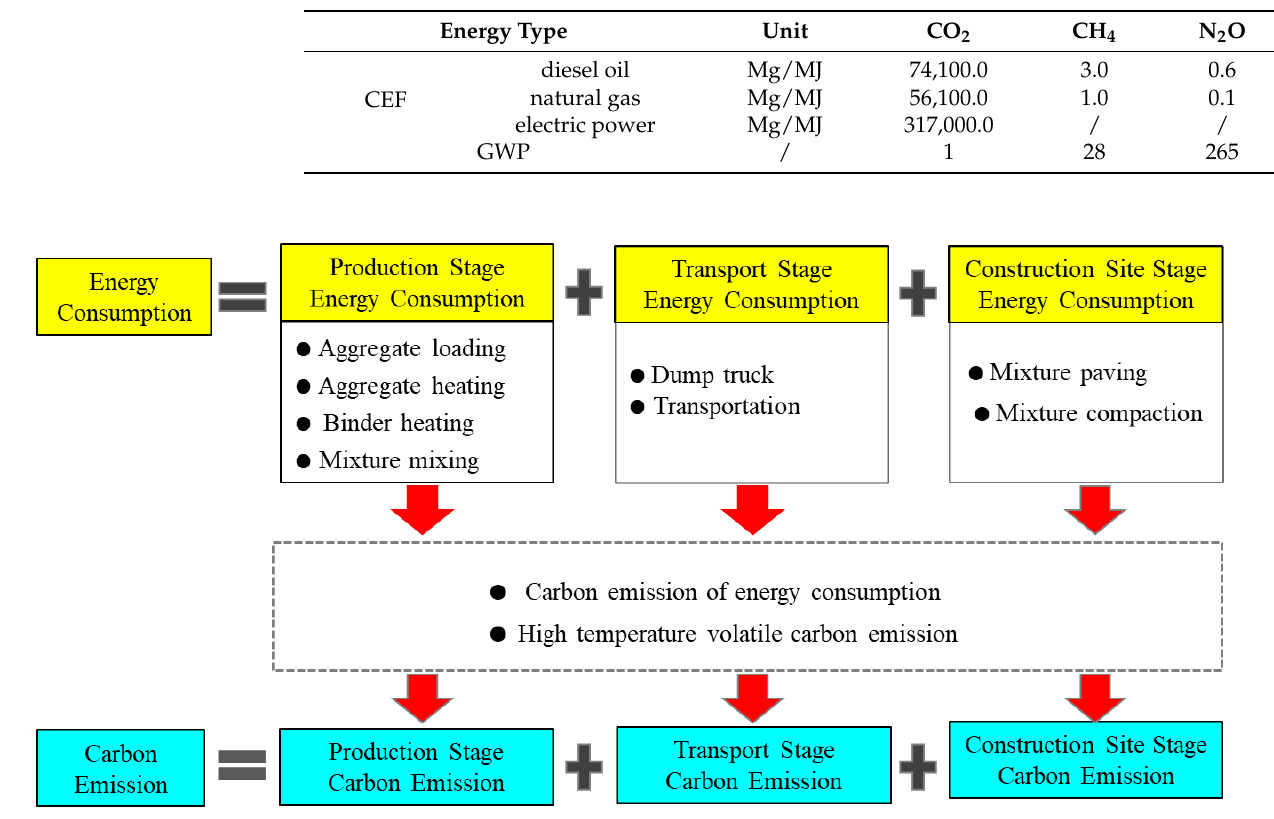
Table 7. CEF and GWP at different energy consumptions.